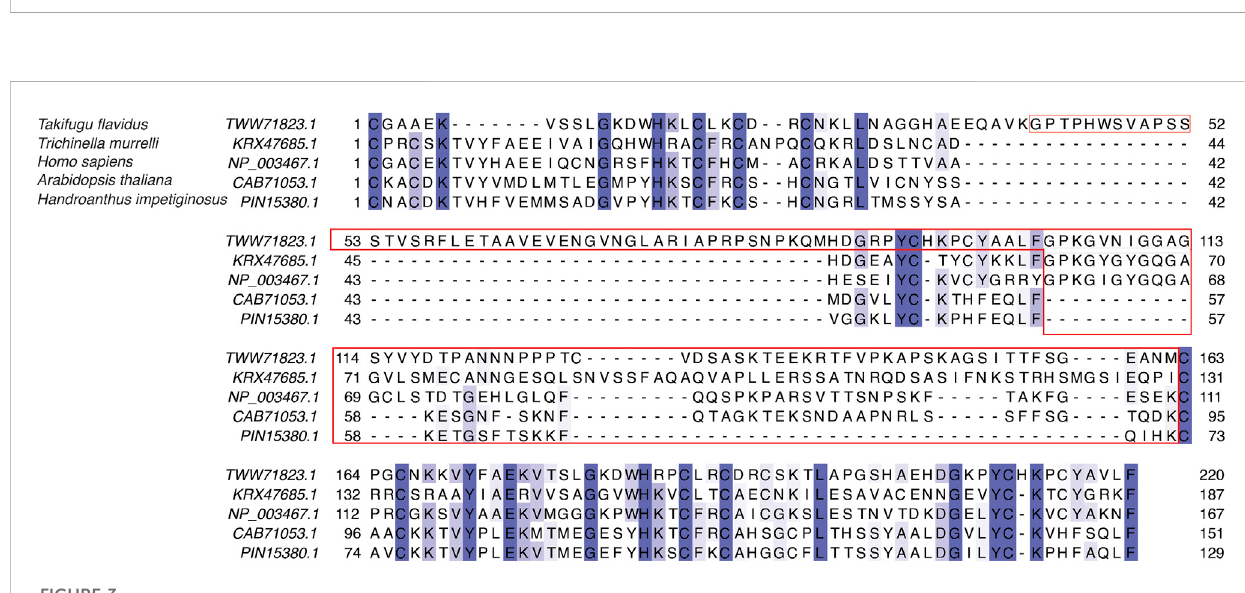
FIGURE 3 Sequence alignment ofLIMdomains andthe disordered linker region inhuman CSRP3 (NP_003467.1),sansaifugu CSRP2(TWW71823.1), nematode CSRP2 KRX47685.1, Arabidopsis LIM domain protein (CAB71053.1), and Handroanthus MLP